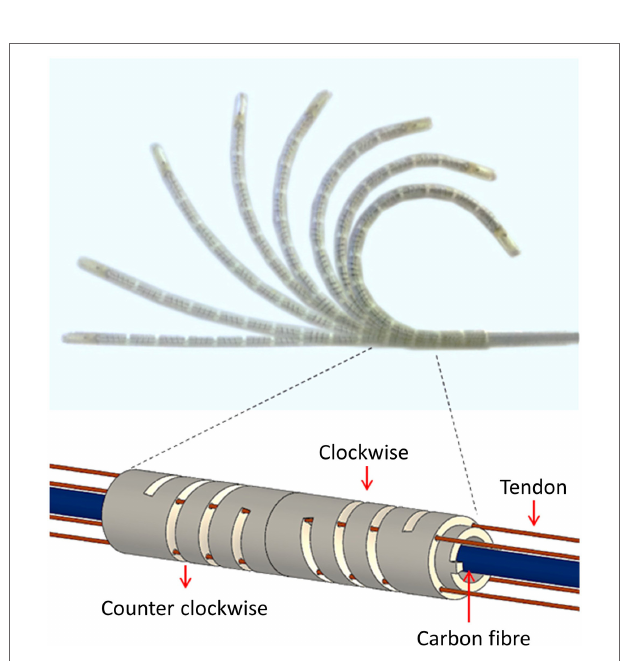
FigUre 3 | Bending motions of the catheter tip and helical segment structure with alternating clockwise and counter-clockwise helix orientations .